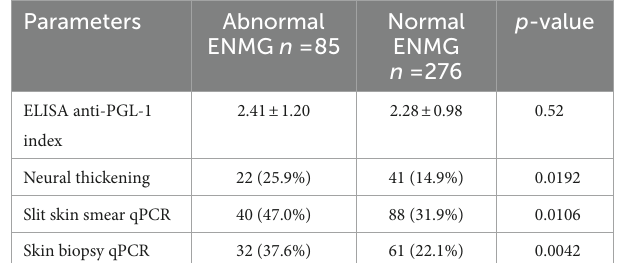
TABLE 6 Distribution seropositive household contacts of leprosy patients according to the electroneuromyographic pattern, and comparisons of